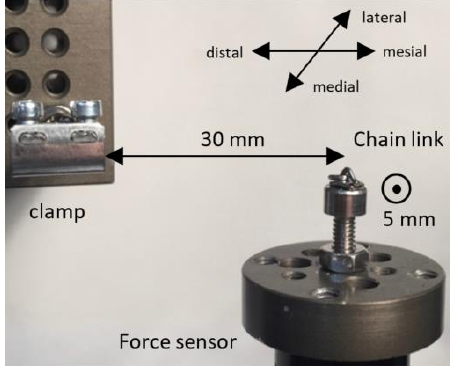
Figure 4. The experimental set-up with the relevant directions and dimensions.